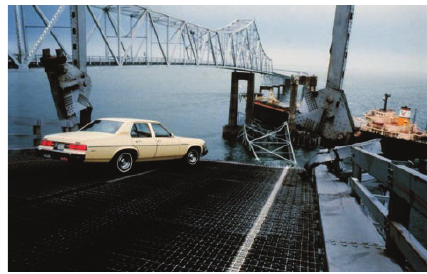
Figure 1: Vessel-bridge collision.